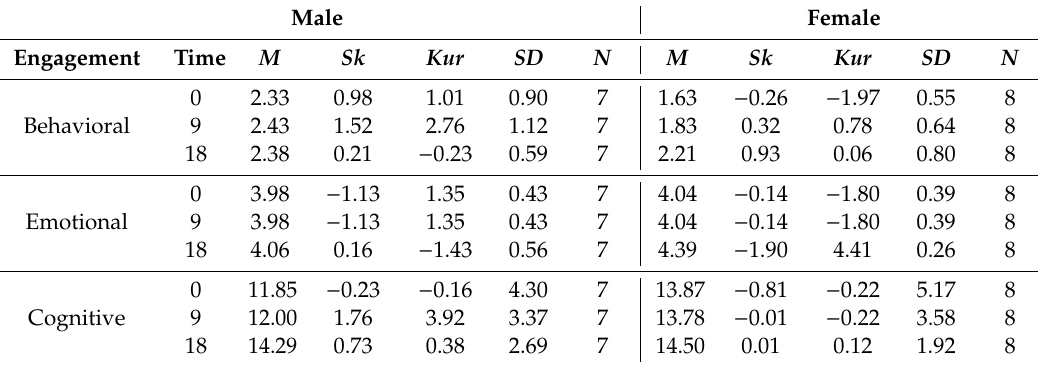
Table 2. Descriptive statistics by sex for each of the three dimensions of School Engagement (SE). Male Female